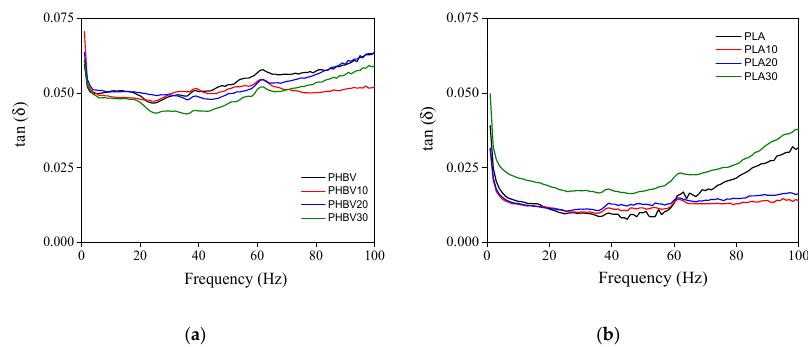
Figure 5. The variation of the loss factor with the frequency for PHBV ( a ) and PLA ( b ) biocomposites.